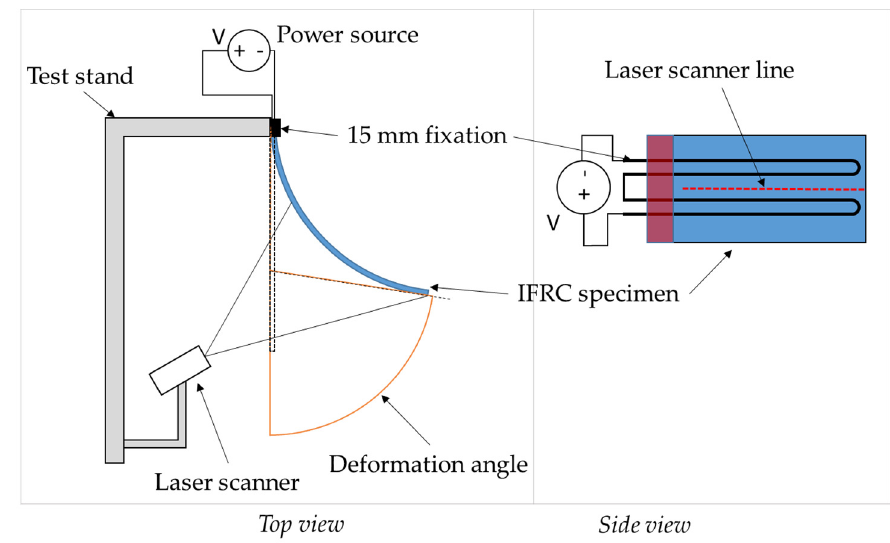
Figure 8. Deformation measurement test stand in top and side views.